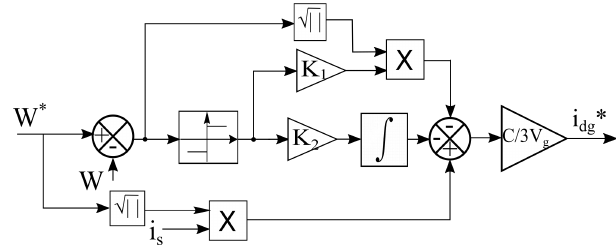
Figure 5 illustrate the block diagram of SMC2.